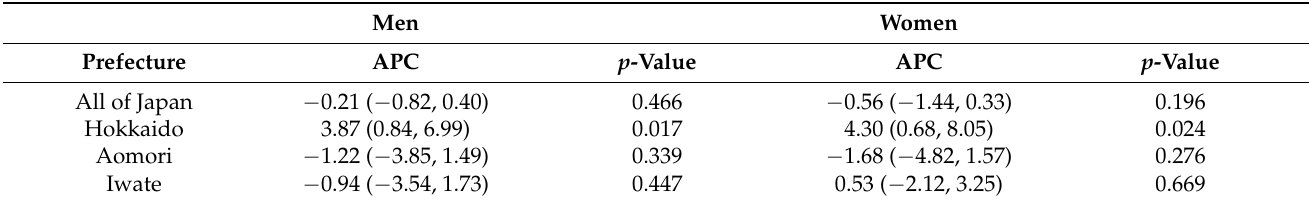
Table 3. APC of age-standardized prevalence of atopic dermatitis for each prefecture. Men